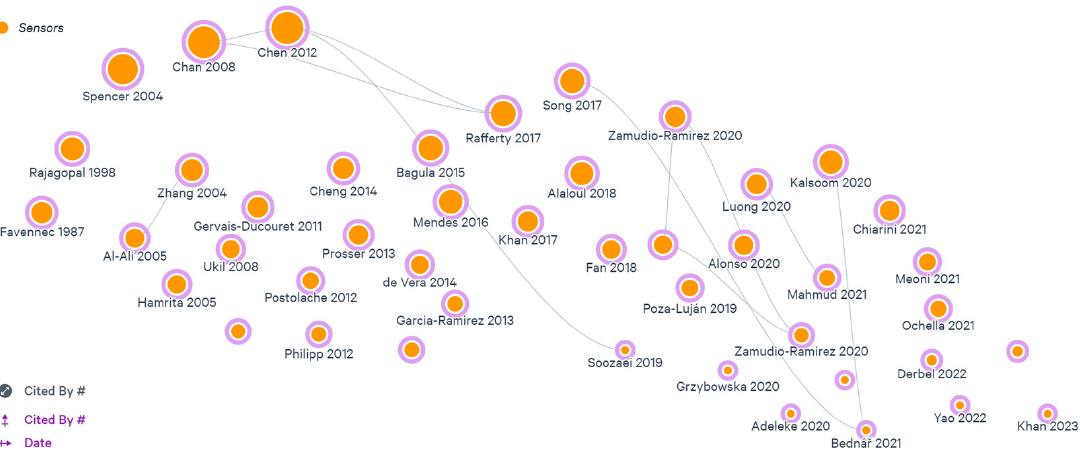
Figure 7. Litmap diagram of citations and years between articles.